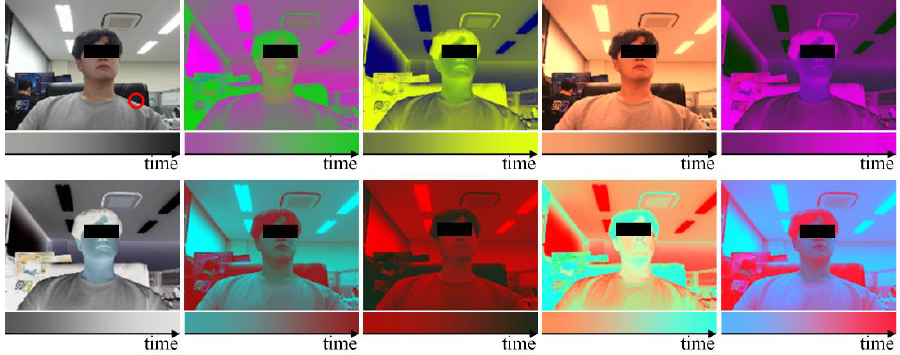
Figure 7. Examples of augmented data used for training.